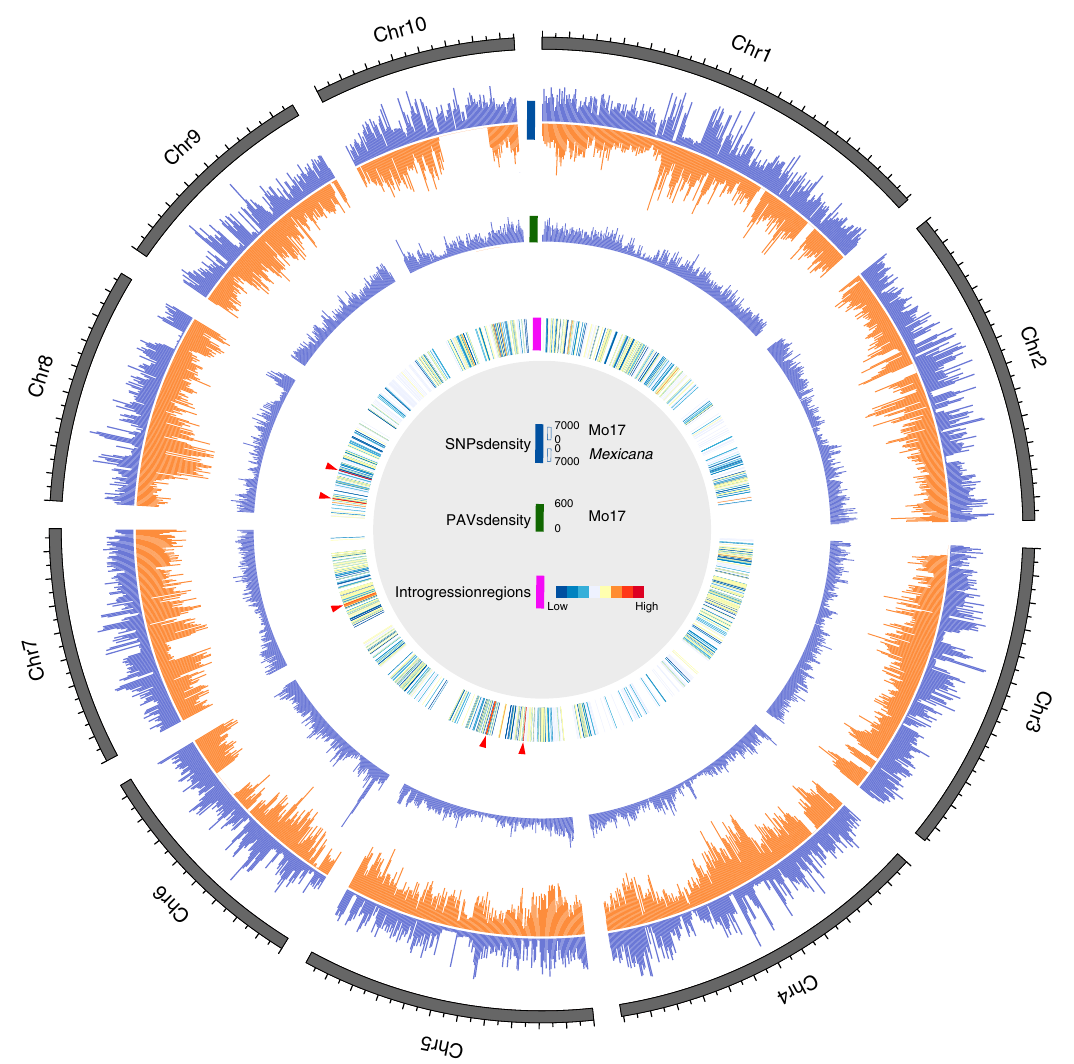
Fig. 2 Comparative analysis of Mo17 and mexicana genomes. Tracks from outer to inner circles indicate: SNPs, PAV density (window size of 1 Mb, the outer and inner layers indicate Mo17 (Blue) and mexicana (Orange)respectively), and a heatmap of introgression, indicating number of lines containing the corresponding introgression region (low = blue; high = red), hotspots are labeled with red